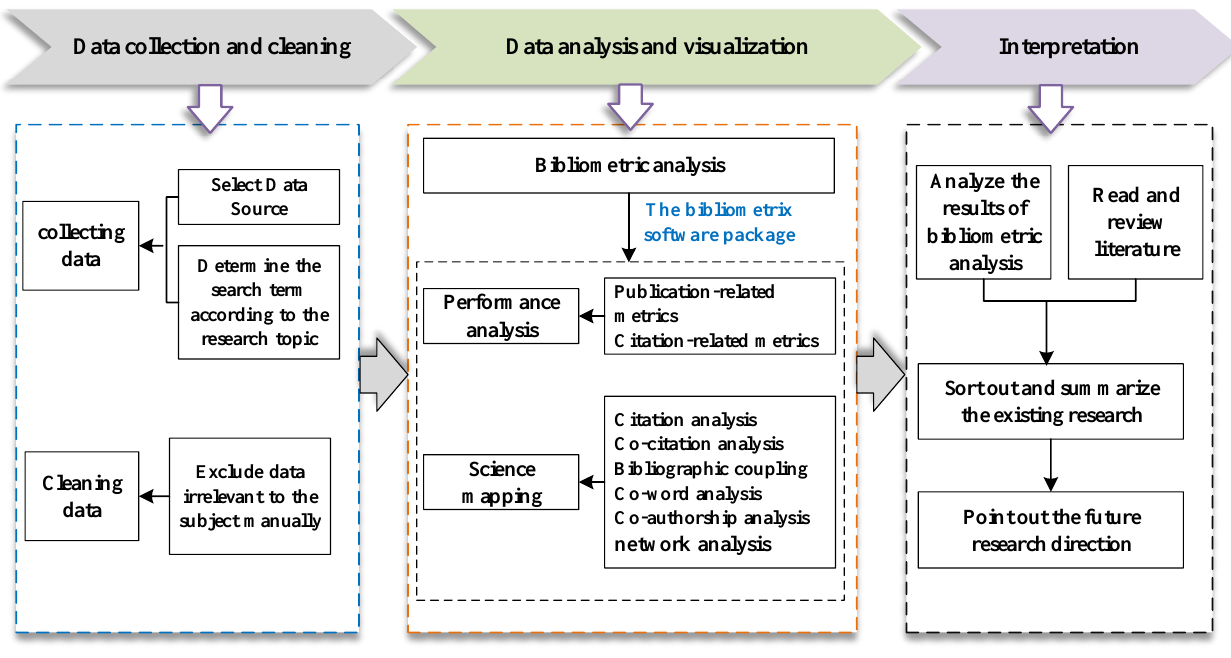
Figure 1. Research design and workflow.